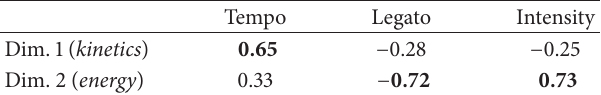
Table 1: Correlation between coordinate axes and acoustic